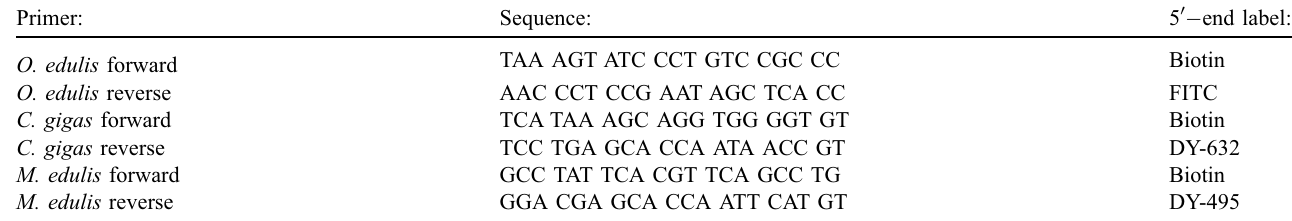
Table 1. Primer pairs targeting the mitochondrial cytochrome b of Ostrea edulis , Crassostrea gigas , and Mytilus edulis . The reverse primers are labelled at 5 0 with a speci fi c dye, respectively the forward primers are labelled at 5 0 with biotin for later implementation to nucleic acid lateral fl ow immunoassay.